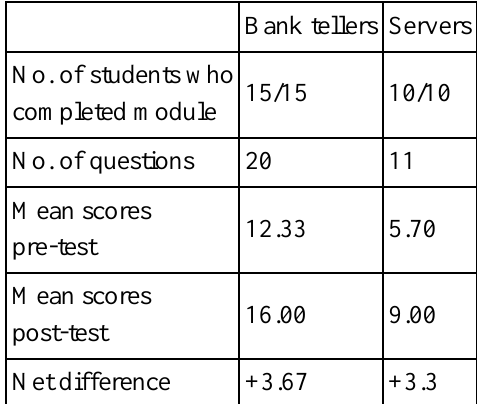
ESPF SMS Quiz Results (Adapted from Ramos, 2008, p.